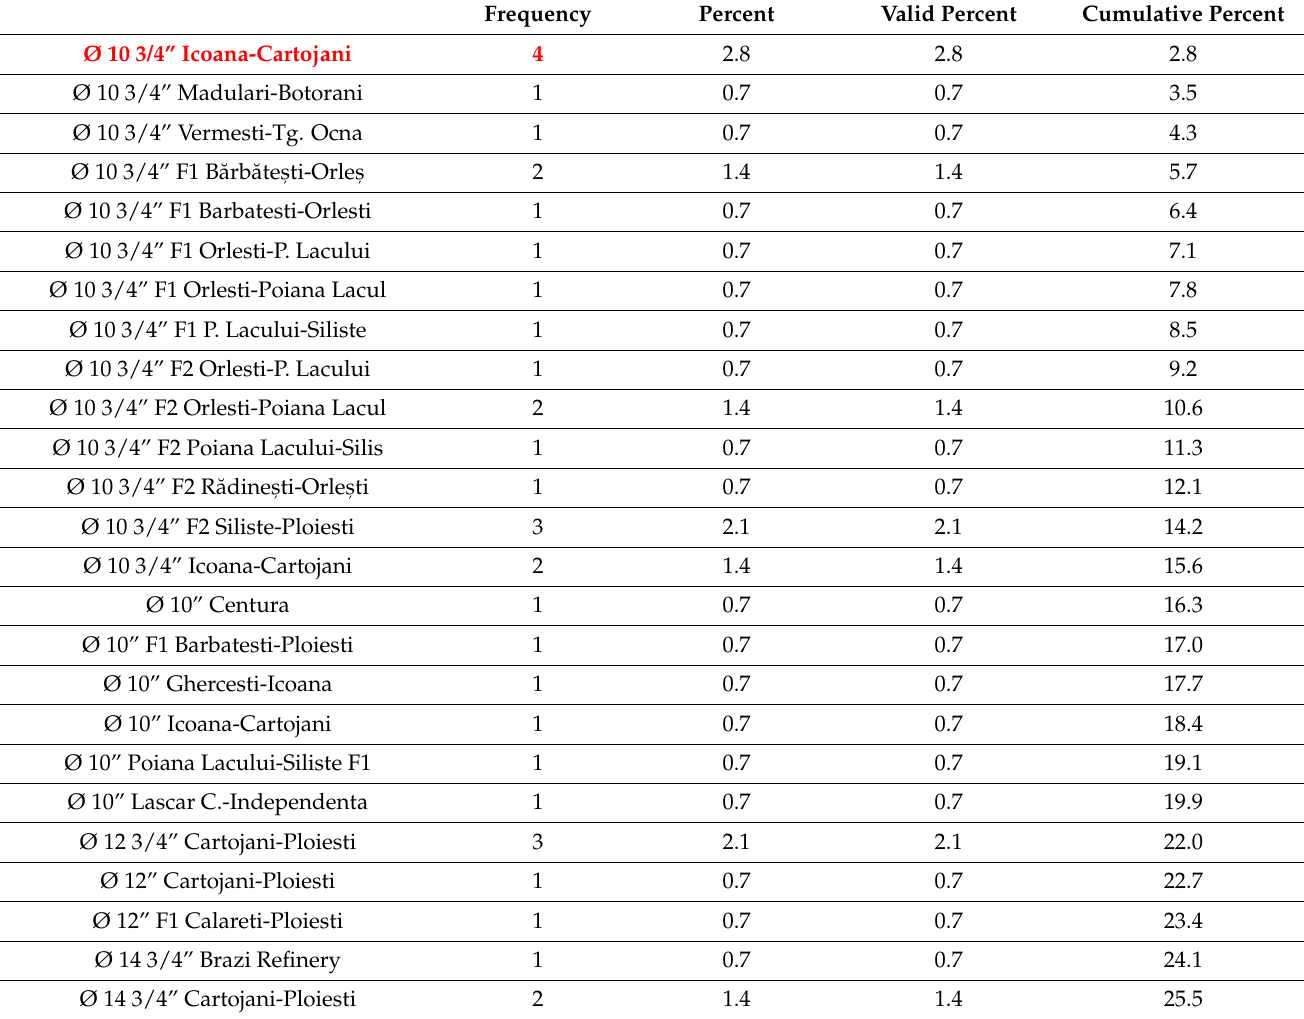
Table 8. Recorded incidents by pipe localization and